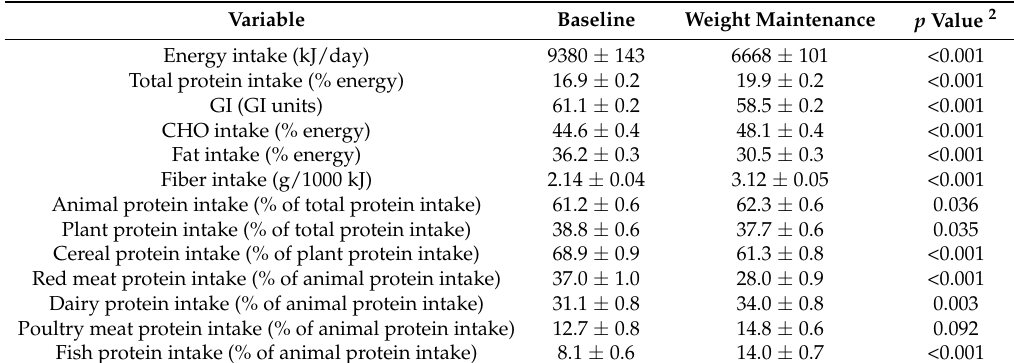
Table 2. Dietary intakes at baseline during the weight maintenance phase 1